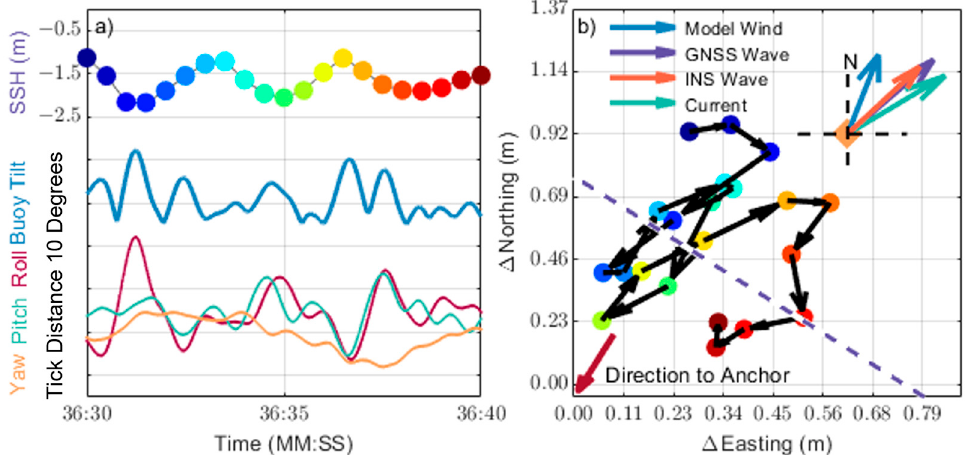
Figure 7. Dynamic close-up of buoy motion over 10 s. Panel ( a ) shows the unsmoothed SSH (coloured dot as a function of time), buoy tilt and the roll-pitch-yaw (RPY) all in the unit of degrees derived from the IMU over the 10-s period. Panel ( b ) shows the horizontal motion in Easting and Northing. The buoy trajectory follows the black arrow between coloured dots (coloured with the same function of time as in Panel ( a )). The purple dashed line is the general direction of the buoy on its watch circle around the anchor location (Figure S1) and the arrow in the bottom-left corner shows the approximate direction of the anchor (not to scale in distance). In the top right corner, four mean directions over the 10-s period, derived from GNSS and INS, observed by current-meter and extracted from the ACCESS-G model are shown.